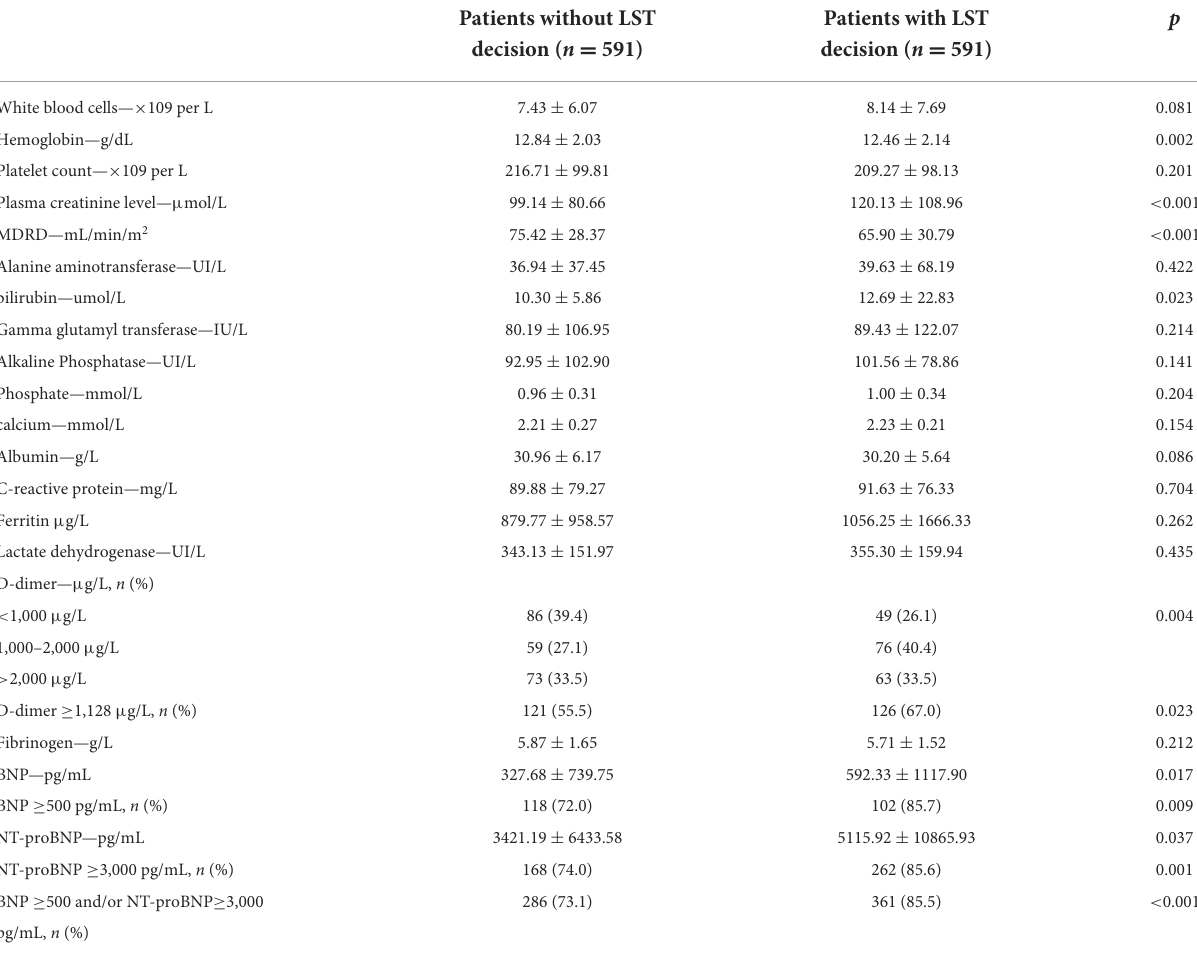
TABLE 2 Baseline biological profile of the population in a retrospective study for a matched population in LST patients with COVID-19 admitted in medical wards. Patients without